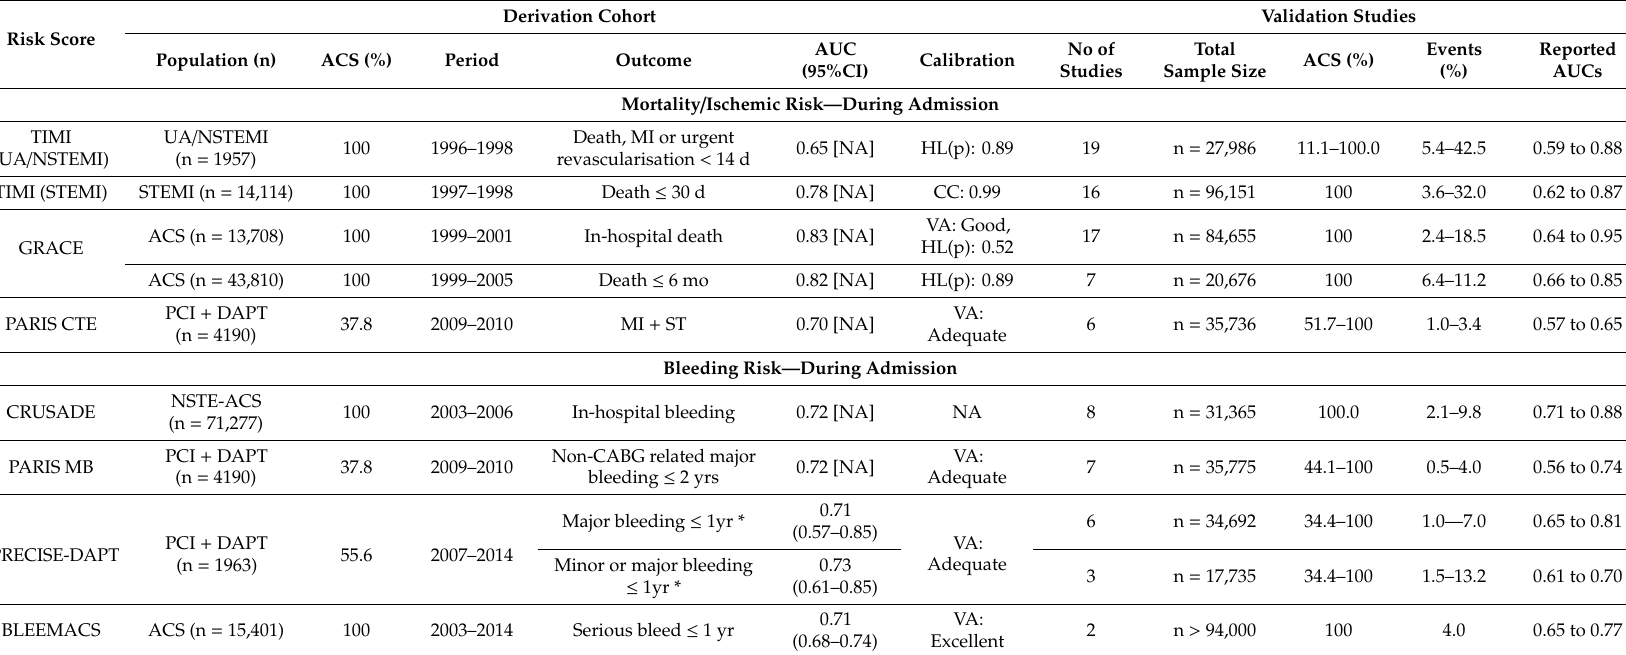
Table 2. Risk scores used during admission for patients with